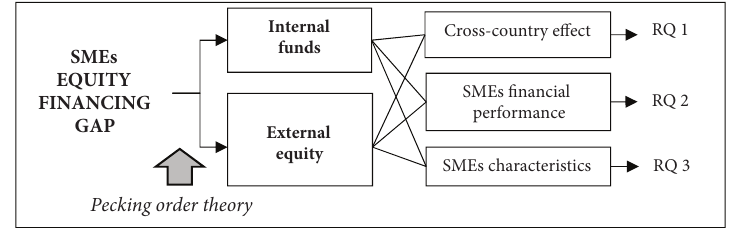
Figure 1. The design of the empirical